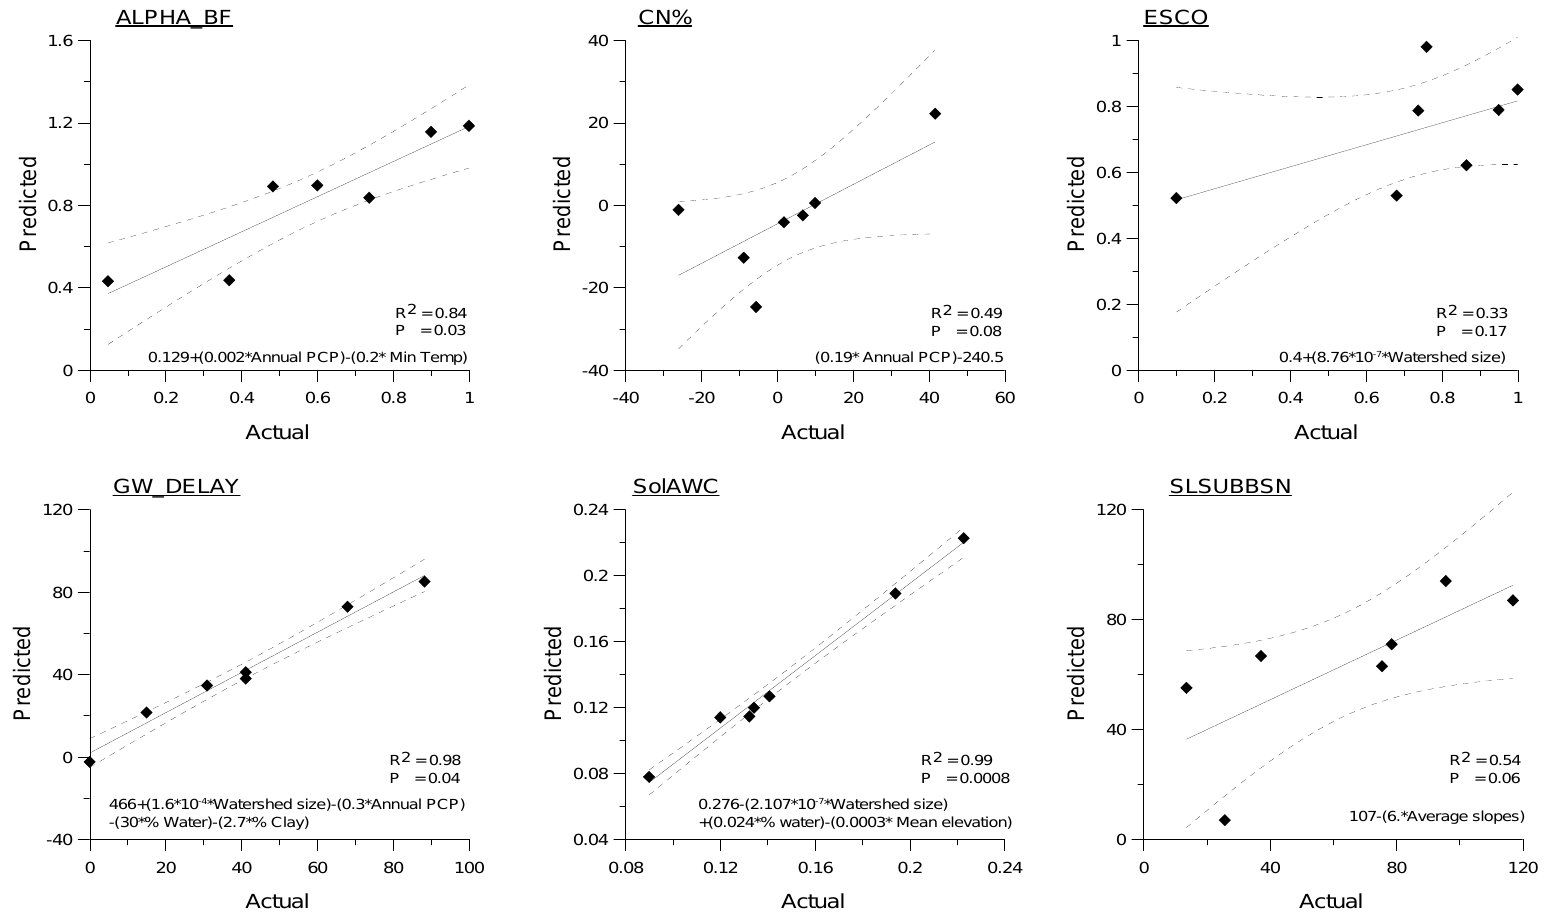
Figure 3. Regression plots, equations and statistics for model parameters for which significant relationships were obtained. Dotted lines represent 95% confidence intervals. R 2 denotes the coefficient of determination, 0 ≤ R 2 ≤ 1. P denotes the probability of obtaining a value of the test statistic (in this case F) that is greater than that